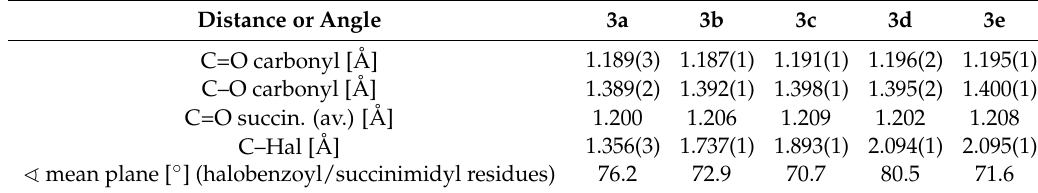
Table 2. Selected atom distances [Å] and mean plane angles [°].